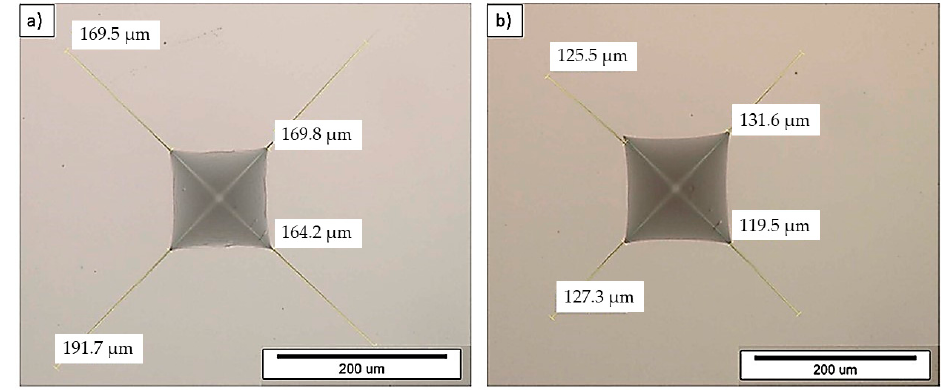
Figure 11. Vickers indentation and cracks on the substrate: ( a ) SH-5; ( b ) SH-15 .